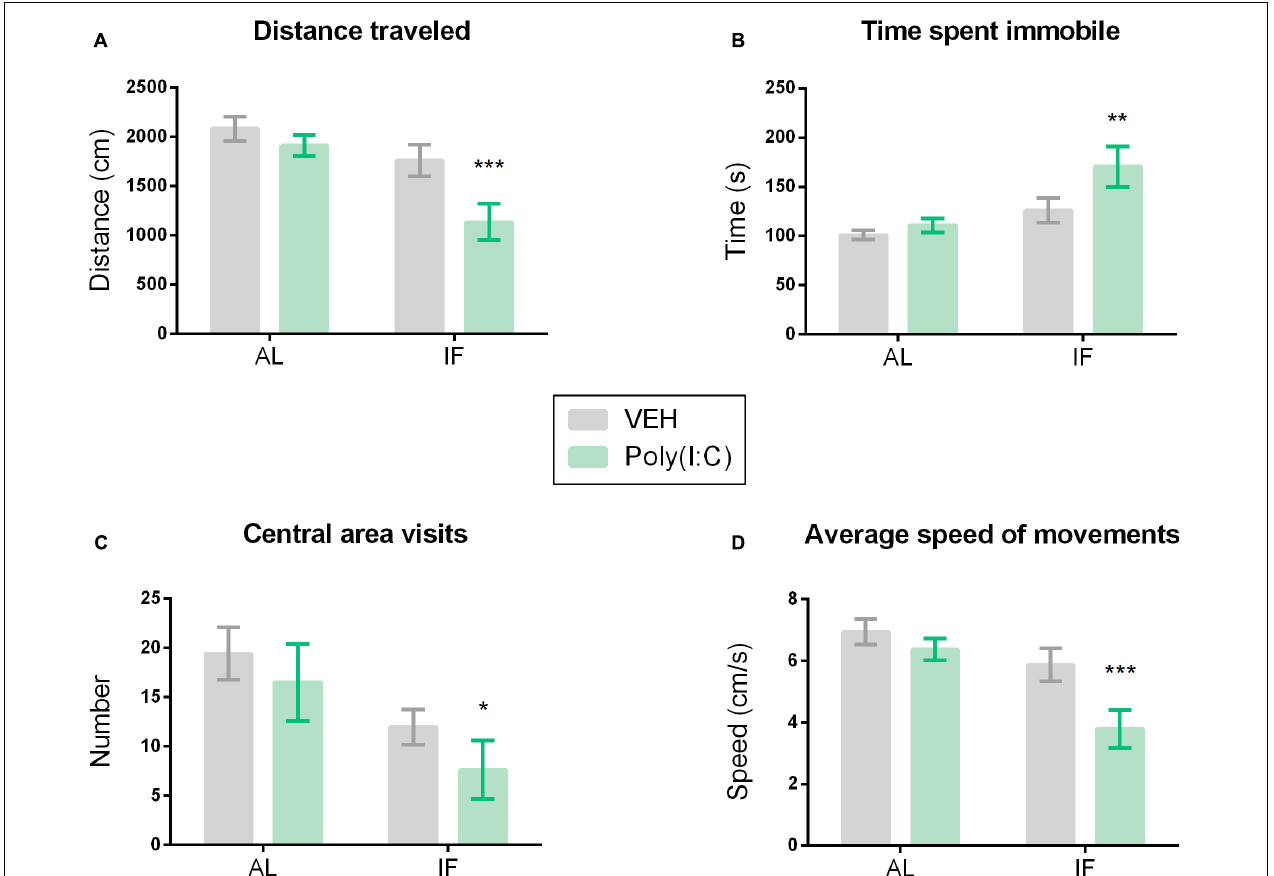
FIGURE 3 | Intermittent fasting induces sickness behavior in response to Poly(I:C). Mice were kept on an ad libitum feeding regimen (AL) or deprived of food on every other day (IF) for 9 days. On day 10, mice were injected i.p. with vehicle (VEH) or Poly(I:C) (12 mg/kg) and 4 h later subjected to the open field (OF) test to evaluate sickness behavior: (A) distance traveled, (B) time spent immobile, (C) visits to the central area of the OF, (D) average speed of movements. Values represent means ± SEM, n = 7–9. Results of two-way ANOVA: F (1, 29) = 2.164, p = 0.1521 for interaction of feeding regimen/Poly(I:C) in distance traveled; F (1, 29) = 12.73, p ≤ 0.01 for main effect of feeding regimen on distance traveled; F (1, 29) = 6.674, p ≤ 0.05 for main effect of Poly(I:C) on distance traveled; F (1, 29) = 1.575, p = 0.2195 for interaction of feeding regimen/Poly(I:C) in time spent immobile; F (1, 29) = 9.330, p ≤ 0.01 for main effect of feeding regimen on time spent immobile; F (1, 29) = 3.813, p = 0.0606 for main effect of i.p. treatment on time spent immobile; F (1, 29) = 0.05753, p = 0.8121 for interaction of feeding/Poly(I:C) in number of central area visits; F (1, 29) = 7.710, p ≤ 0.01 for main effect of IF on number of central area visits; F (1, 29) = 1.537, p = 0.2249 for main effect of i.p. treatment on number of central area visits; F (1, 29) = 2.163, p = 0.1521 for interaction of feeding regimen/Poly(I:C) in speed of movements; F (1, 29) = 12.72, p ≤ 0.01 for main effect of feeding regimen on speed of movements; F (1, 29) = 6.673, p ≤ 0.05 for main effect of Poly(I:C) on speed of movements. Results of Sidak’s multiple comparison test: ∗ p ≤ 0.05, ∗∗ p ≤ 0.01, ∗∗∗ p ≤ 0.001 compared to